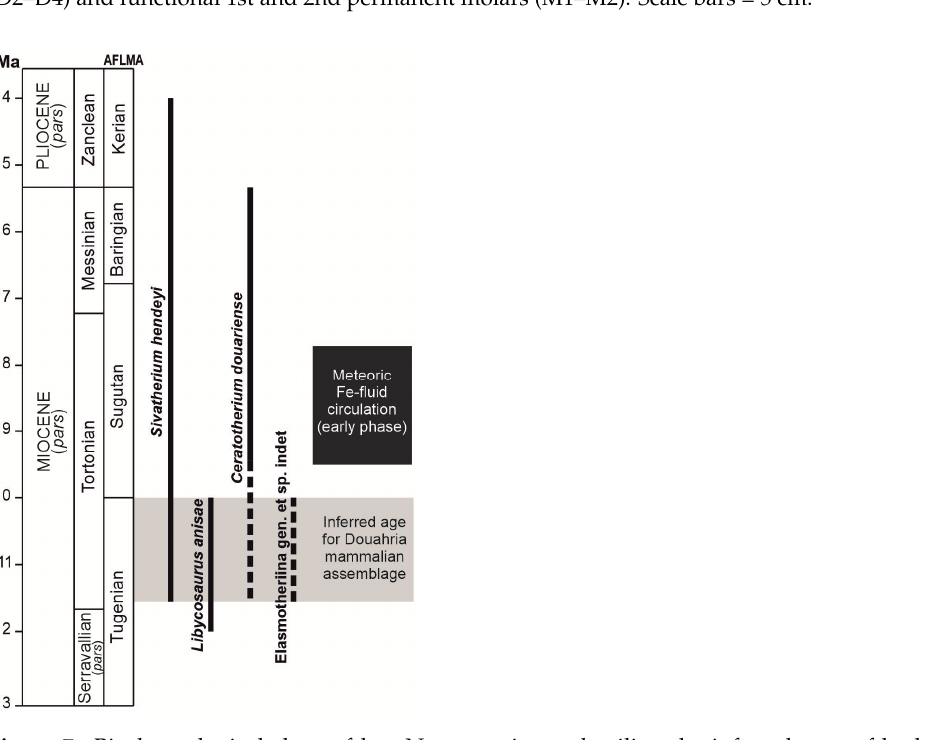
Figure 6. Selected rhinocerotid remains from the early Tortonian Douahria fossil locality, Tunisia. ( A , B ), Ceratotherium douariense [19], adult skull FSL 16749 (holotype). ( A ), right lateral view; ( B ), palatine view, with left and right dental series (premolars (P2–P4) and molars (M1–M3)). ( C – F ), Unidentified elasmotheriine, juvenile skull FSL 16752 (formerly paratype of C. douariense ). ( C ), right lateral view; ( D ), dorsal view; ( E ), detailed occlusal view of the left dental series, with emerging 2nd and 3rd premolars (P2–P3); ( F ), detailed occlusal view of the right dental series, with decidual teeth (D2–D4) and functional 1st and 2nd permanent molars (M1–M2). Scale bars = 5 cm.